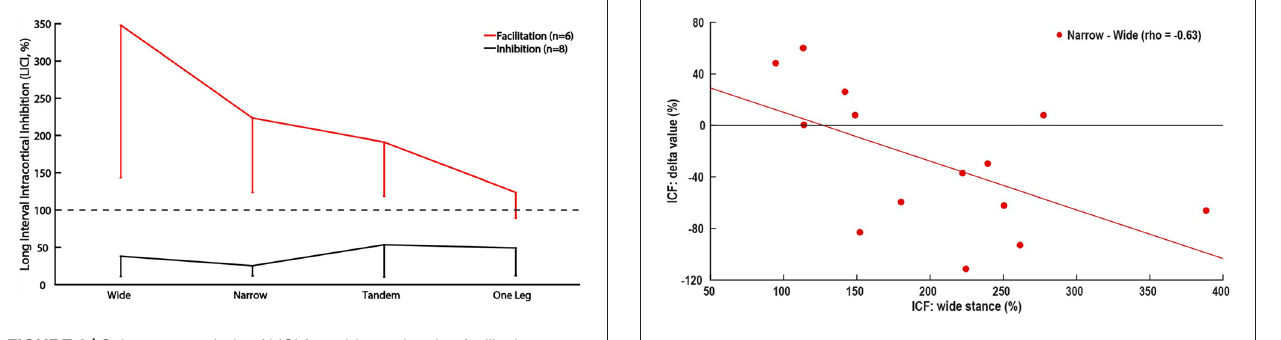
FIGURE 2 | Sub-group analysis of LICI for subjects showing facilitation vs. inhibition. The vertical bars represent standard deviation. Horizontal line indicates size of control MEP, values greater than 100% indicate facilitation.